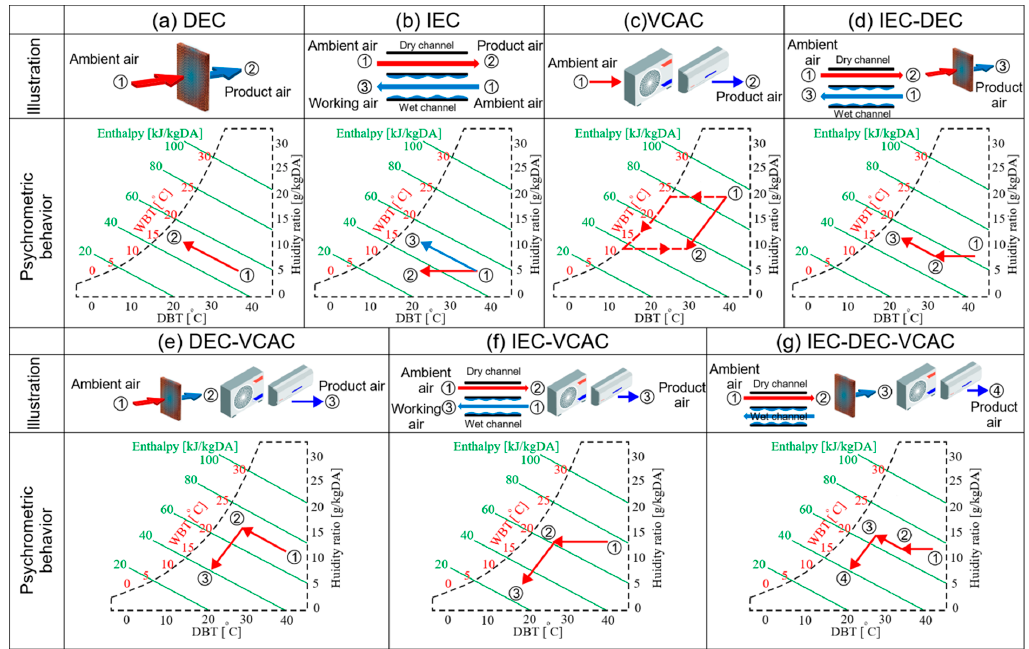
Figure 2. Schematic illustrations and the corresponding psychrometric behavior for seven proposed configurations of EC and VCAC systems: ( a ) DEC, ( b ) IEC, ( c ) VCAC, ( d ) IEC-DEC, ( e ) DEC-VCAC, ( f ) IEC-VCAC, and ( g ) IEC-DEC-VCAC.